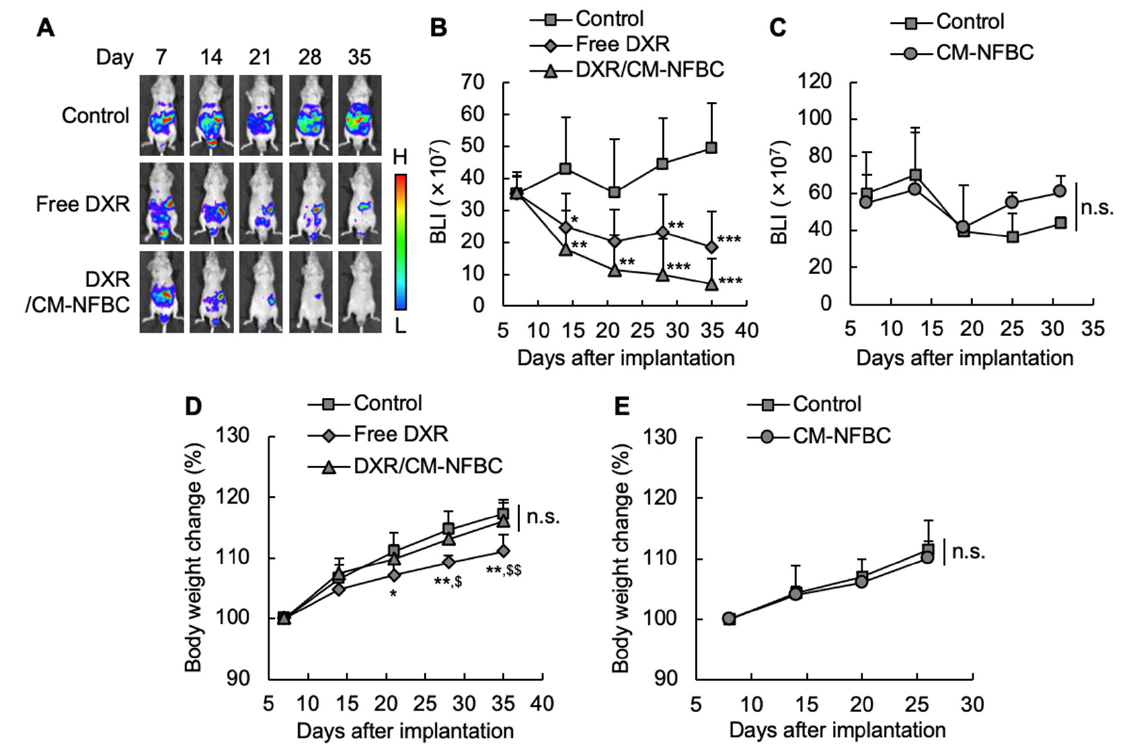
Figure 3. Growth inhibitory effect of an intraperitoneally injected DXR/CM-NFBC formulation on peritoneally inoculated NCI-N87-Luc tumors. Peritoneally disseminated gastric cancer (NCI-N87-Luc) xenograft model mice were intraperitoneally injected with four doses of either free DXR, the DXR/CM-NFBC formulation (0.5 mg DXR/kg/day), or CM-NFBC alone once a week from Day 8 post-tumor-inoculation. At selected time points post-tumor-inoculation, luciferase activity of the peritoneally metastatic tumors was monitored with IVIS. ( A ) Bioluminescence intensity (BLI) of peritoneally inoculated NCI-N87-Luc cells in each mouse treated with various formulations. Photos are typical examples from six mice. ( B ) The BLI of interest in the mice treated with various formulations. ( C ) The BLI of interest in the mice treated with CM-NFBC alone. ( D ) Body weight changes in the mice treated with various formulations. ( E ) Body weight changes in the mice treated with CM-NFBC alone. Data represent the mean ± SD ( n = 6, * p < 0.05, ** p < 0.01, *** p < 0.001 vs. control, $ p < 0.05, $$ p < 0.01 vs. DXR/CM-NFBC, n.s.: no significance). Table 1. Tumor growth inhibitory effects of the DXR/CM-NFBC formulation. (* p < 0.05, ** p < 0.01, *** p < 0.001 vs. control).